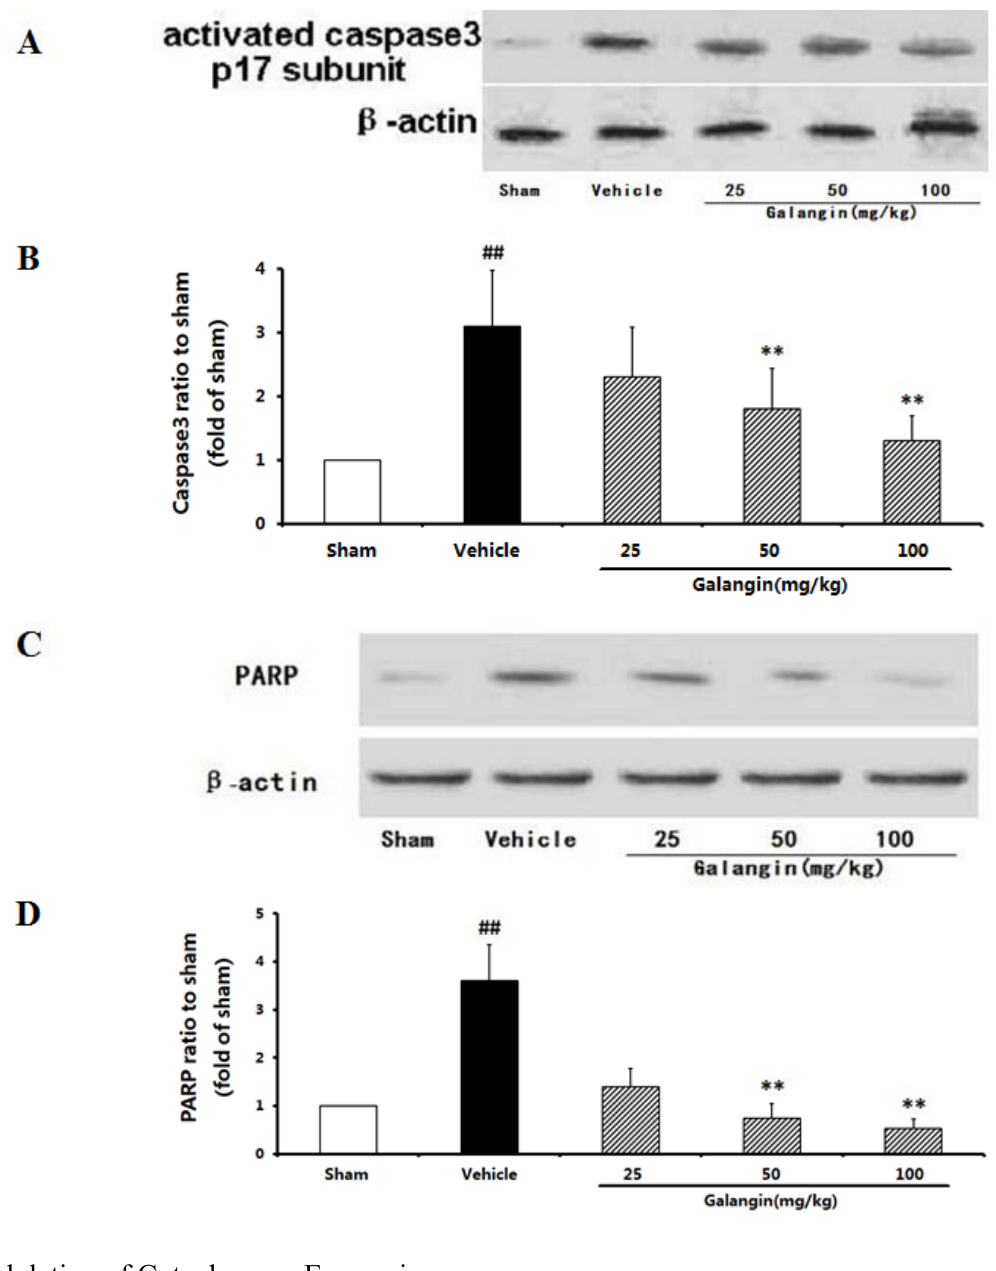
Figure 10. Effects of galangin on caspase-3 and PARP expression in rat brain 24 h after MCAO. Galangin was administered by i.g. 15 min prior to MCAO. ( A ) Representative western blots of caspase-3 and β -actin; ( B ) The quantified densitometric analysis of caspase-3; ( C ) Representative western blots of PARP cleavage and β -actin; ( D ) The quantified densitometric analysis of PARP cleavage. The values were expressed as the mean ± SD for four independent experiments, and the data were analyzed by one-way